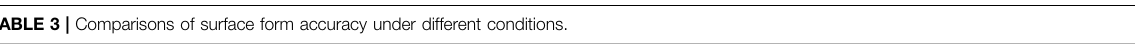
TABLE 3 | Comparisons of surface form accuracy under different